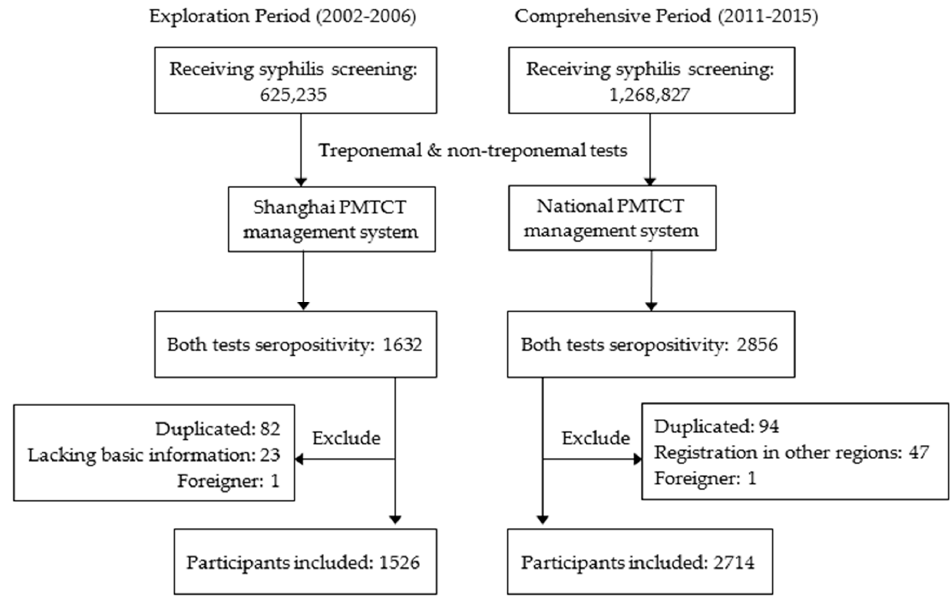
Figure 1. Inclusion of study participants.